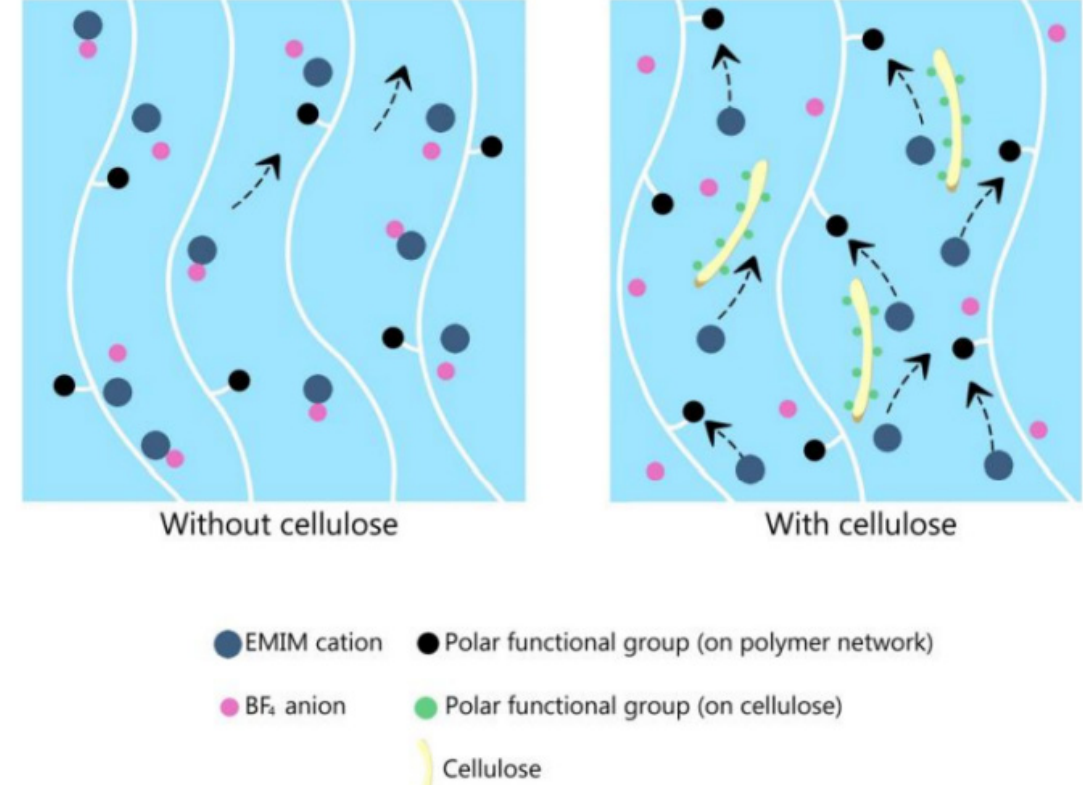
Figure 13. Ion pathway of the ion gel PHEMA-co-PEGDMA/[EMI][BF 4 ]. Reprinted 2018 from [94] with permission from the European Chemical Societies.